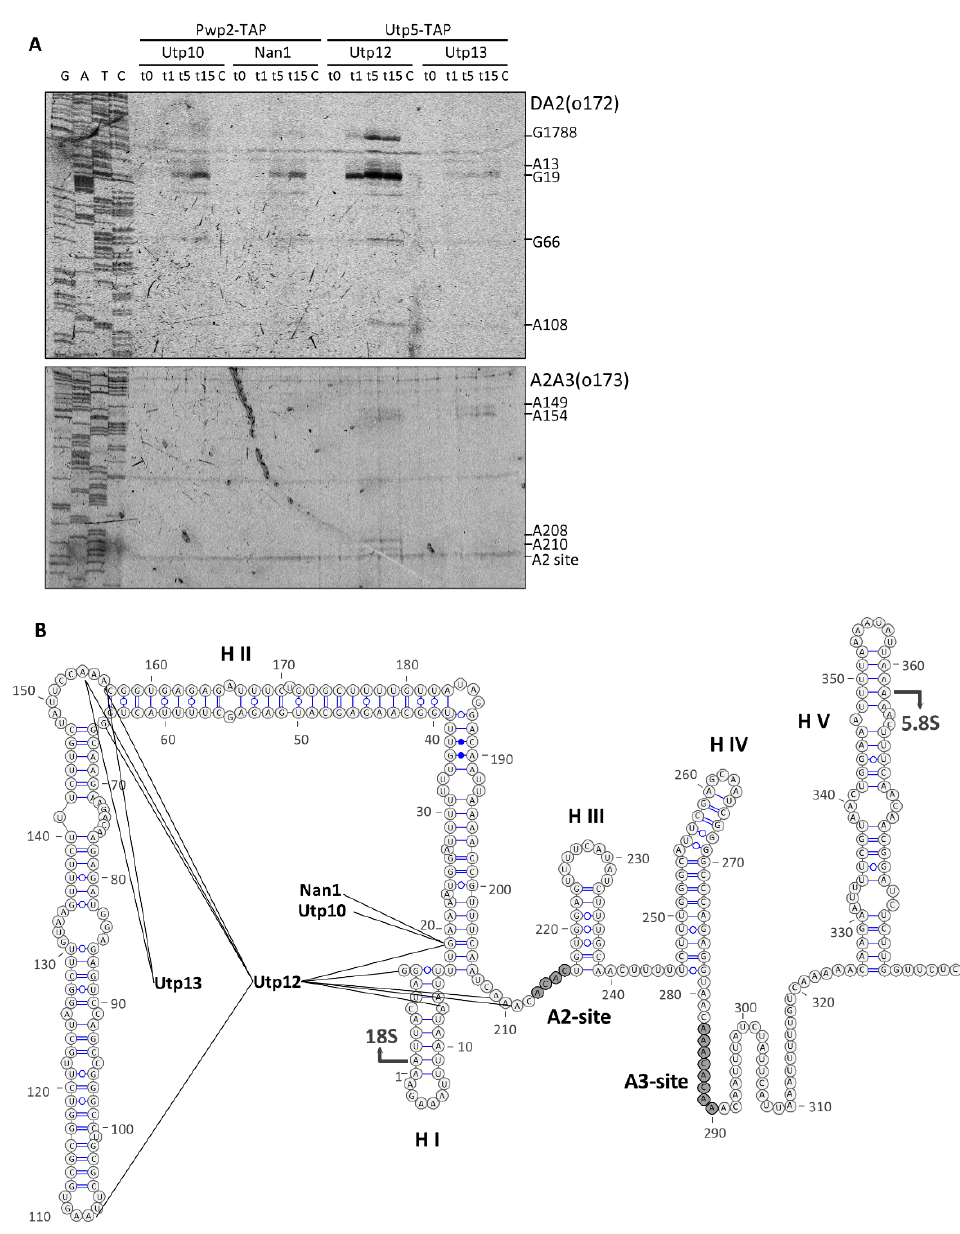
Figure 5. Characterization in the ITS1 region of RNA fragments obtained after MNase treatment. Purified particles were incubated in the presence of CaCl 2 for 10 min, and RNA fragments were obtained by hot phenol extraction and used for primer extension analysis with fluorescent oligonu- cleotides. ( A ) The ITS1 region was explored using oligonucleotides that base pair in the ITS1 either between the cleavage sites D-A2 (upper panel) or between A2 and A3 (lower panel). ( B ) Stops in the reverse transcription observed in A and B were plotted in the schematic representation of the ITS1 region (according to [13]). Components of the UTP complexes fused to either TAP or MNase are indicated on top, and probes used for primer extension are indicated at the top right of the panels. Some nucleotides at prominent stops are indicated on the right side.